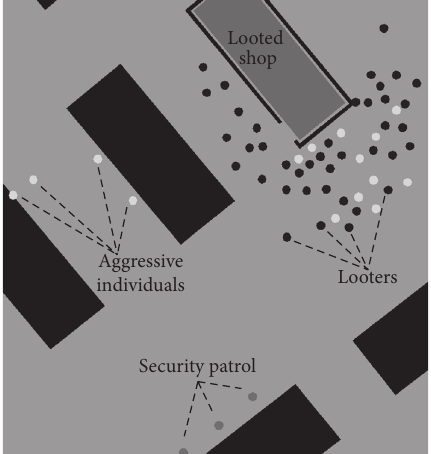
Figure 1: Initial setting of the simulation scenario.